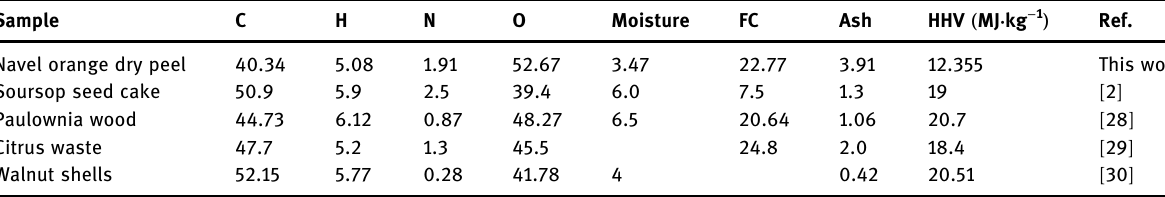
Table 2: Elemental and proximate analysis of air - dried orange peel ( wt% )